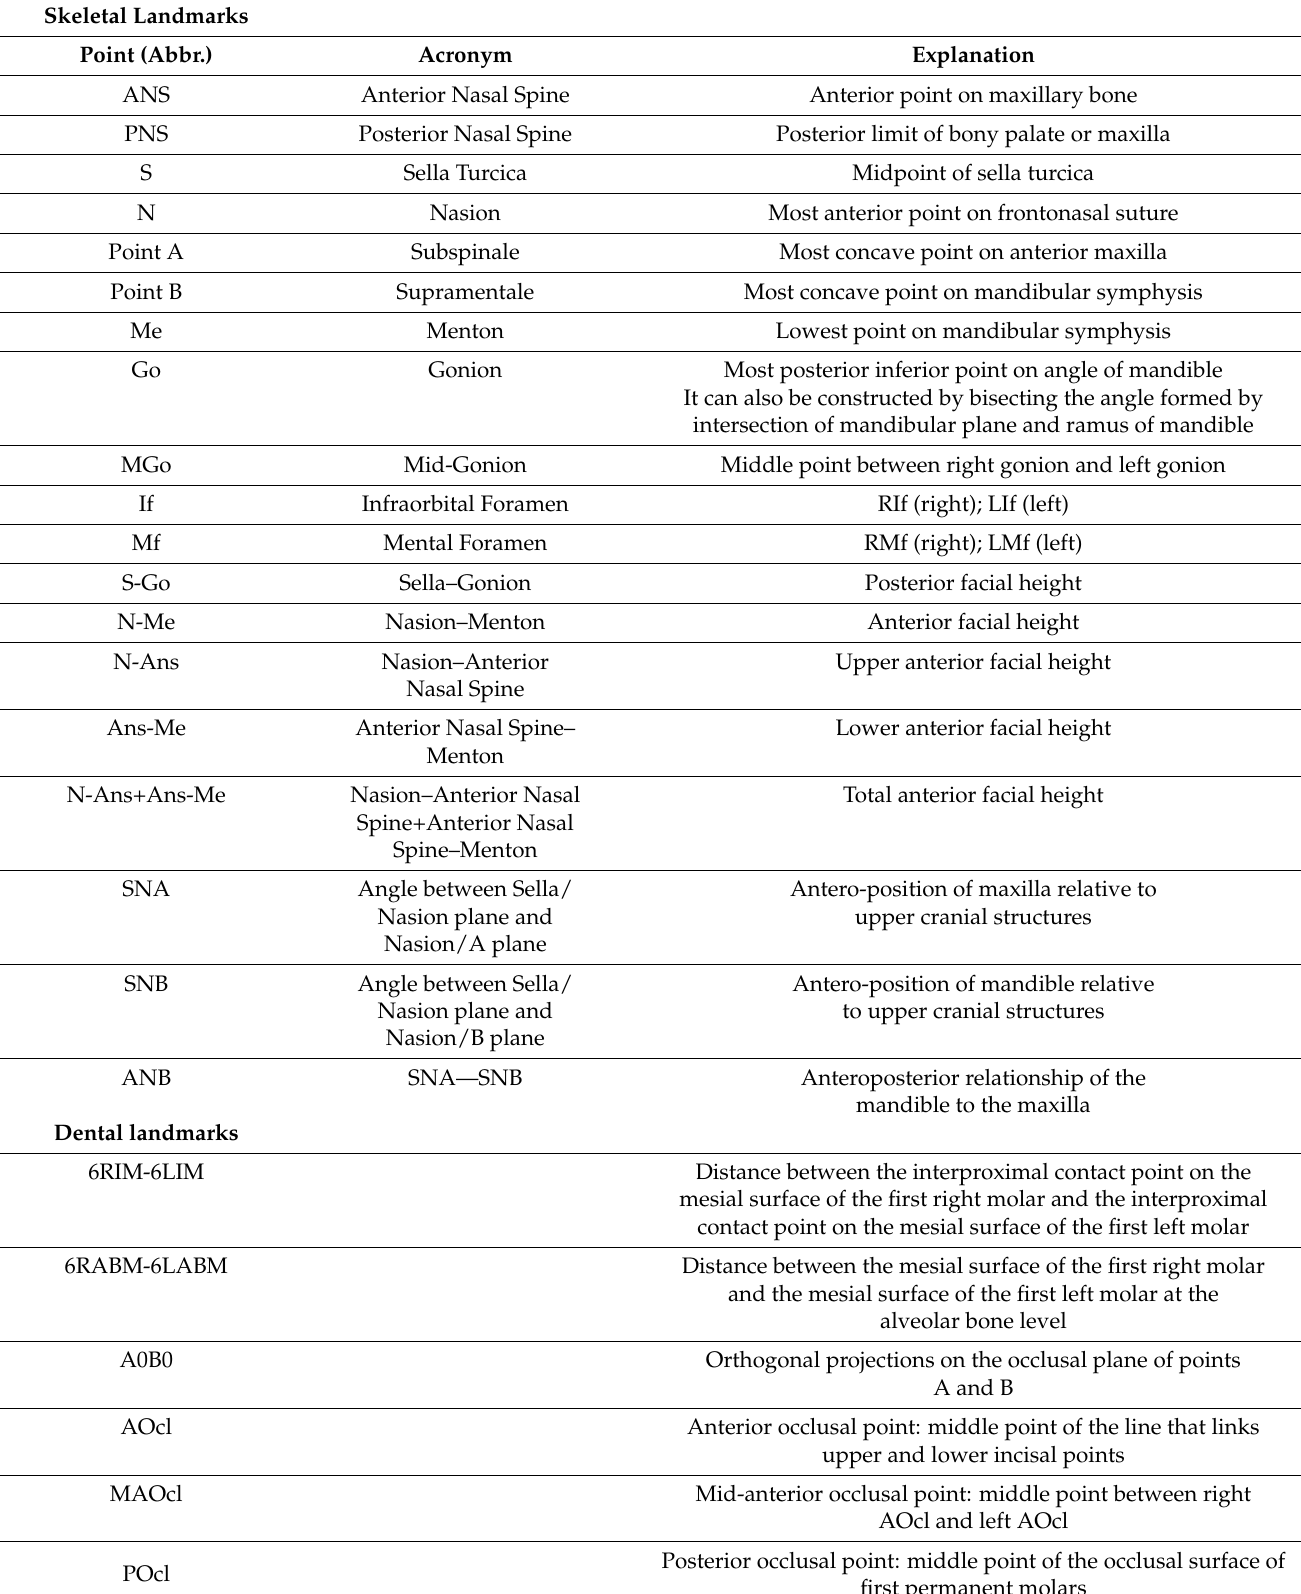
Table 1. Skeletal and dental landmarks for cephalometric